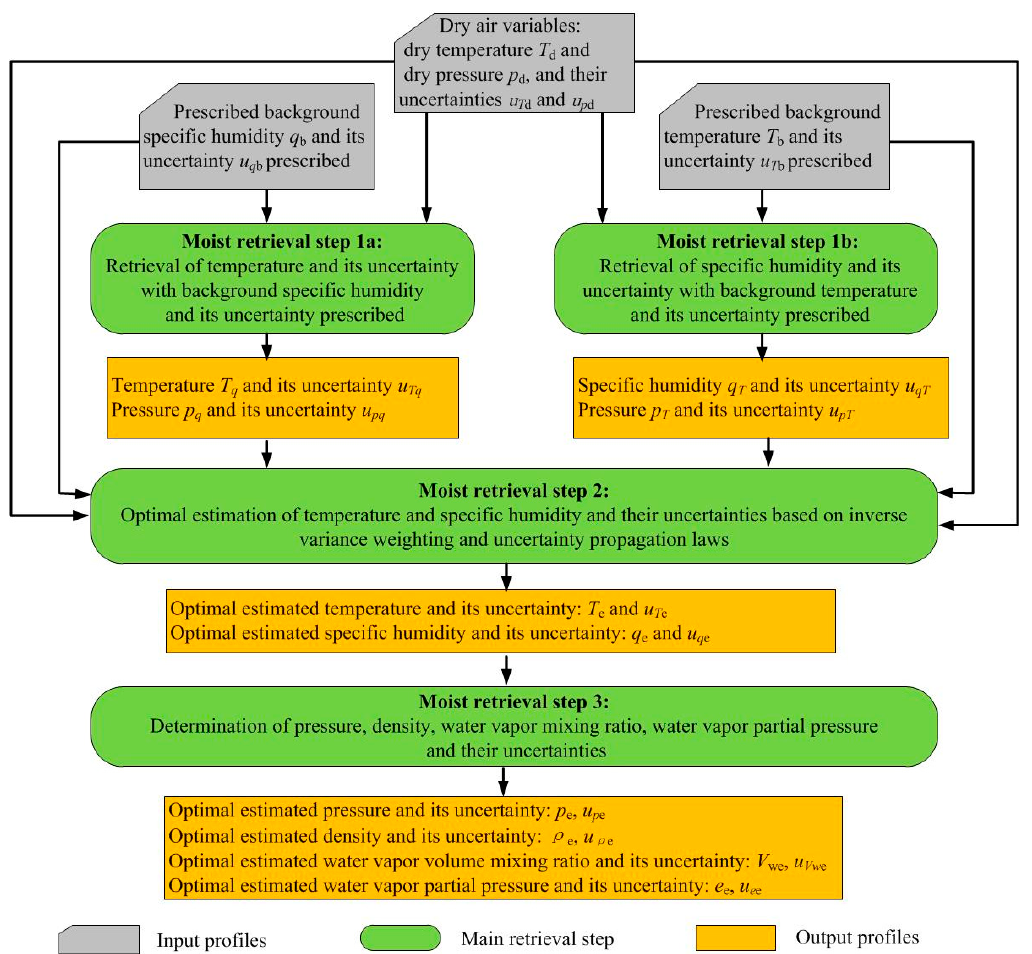
Figure 1. Schematic illustration of the algorithmic steps of the new moist air retrieval algorithm, for description see Section 2.